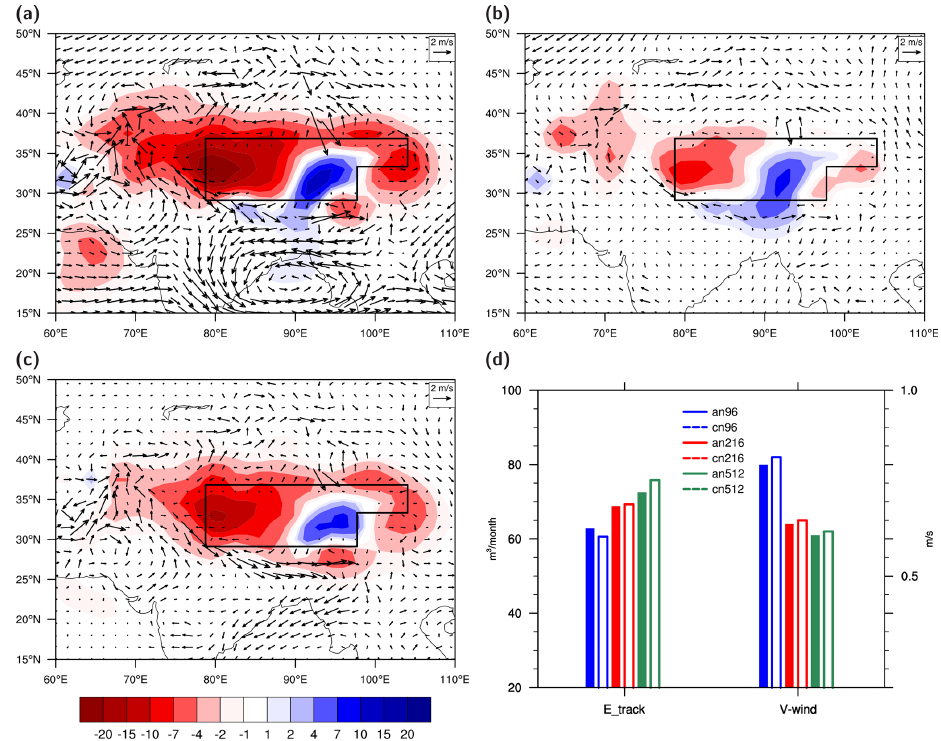
Figure 8. Difference of tracked evaporation (colour; units: mmpermonth) and 700hPa wind (vector; units: ms − 1 ) in JJA over the Tibetan Plateau (region 2) between (a) CN512 and AN96; (b) CN512 and CN216; and (c) CN216 and CN96. (d) Seasonal mean tracked evaporation (E_track; units: m 3 permonth) over eastern Tibet and the 700hPa meridional wind (V wind; units: ms − 1 ) along the southern boundary of the eastern Tibetan